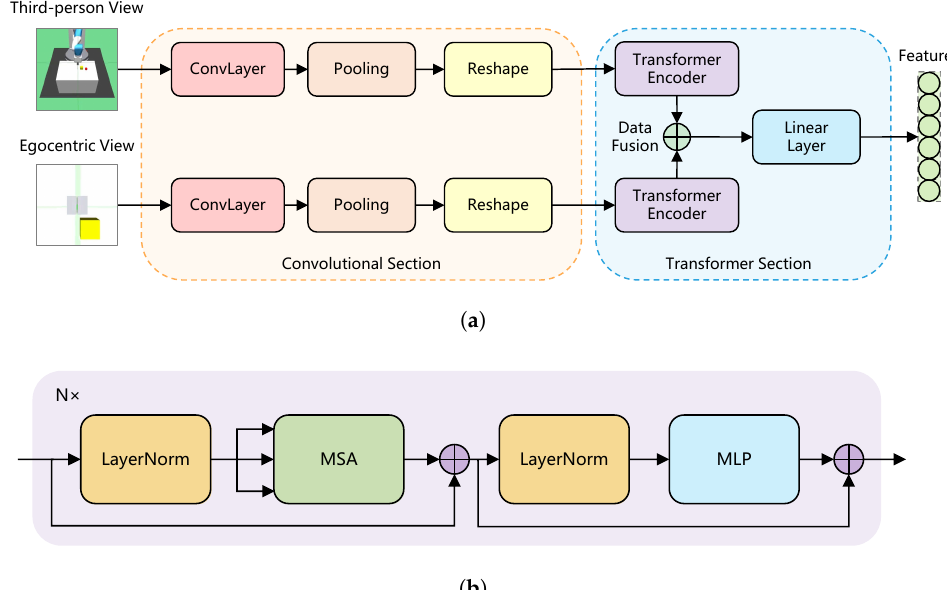
Figure 2. ViT encoder architecture. Observations from each view are divided into respective process channels. The images are encoded to patches and be tokenized by pooling and reshaping for the Transformer, and the output vectors of each Transformer encoder are data fused into a single vector, which is extracted features by the final linear layer. ( a ) DCCT visual encoder; ( b ) Transformer